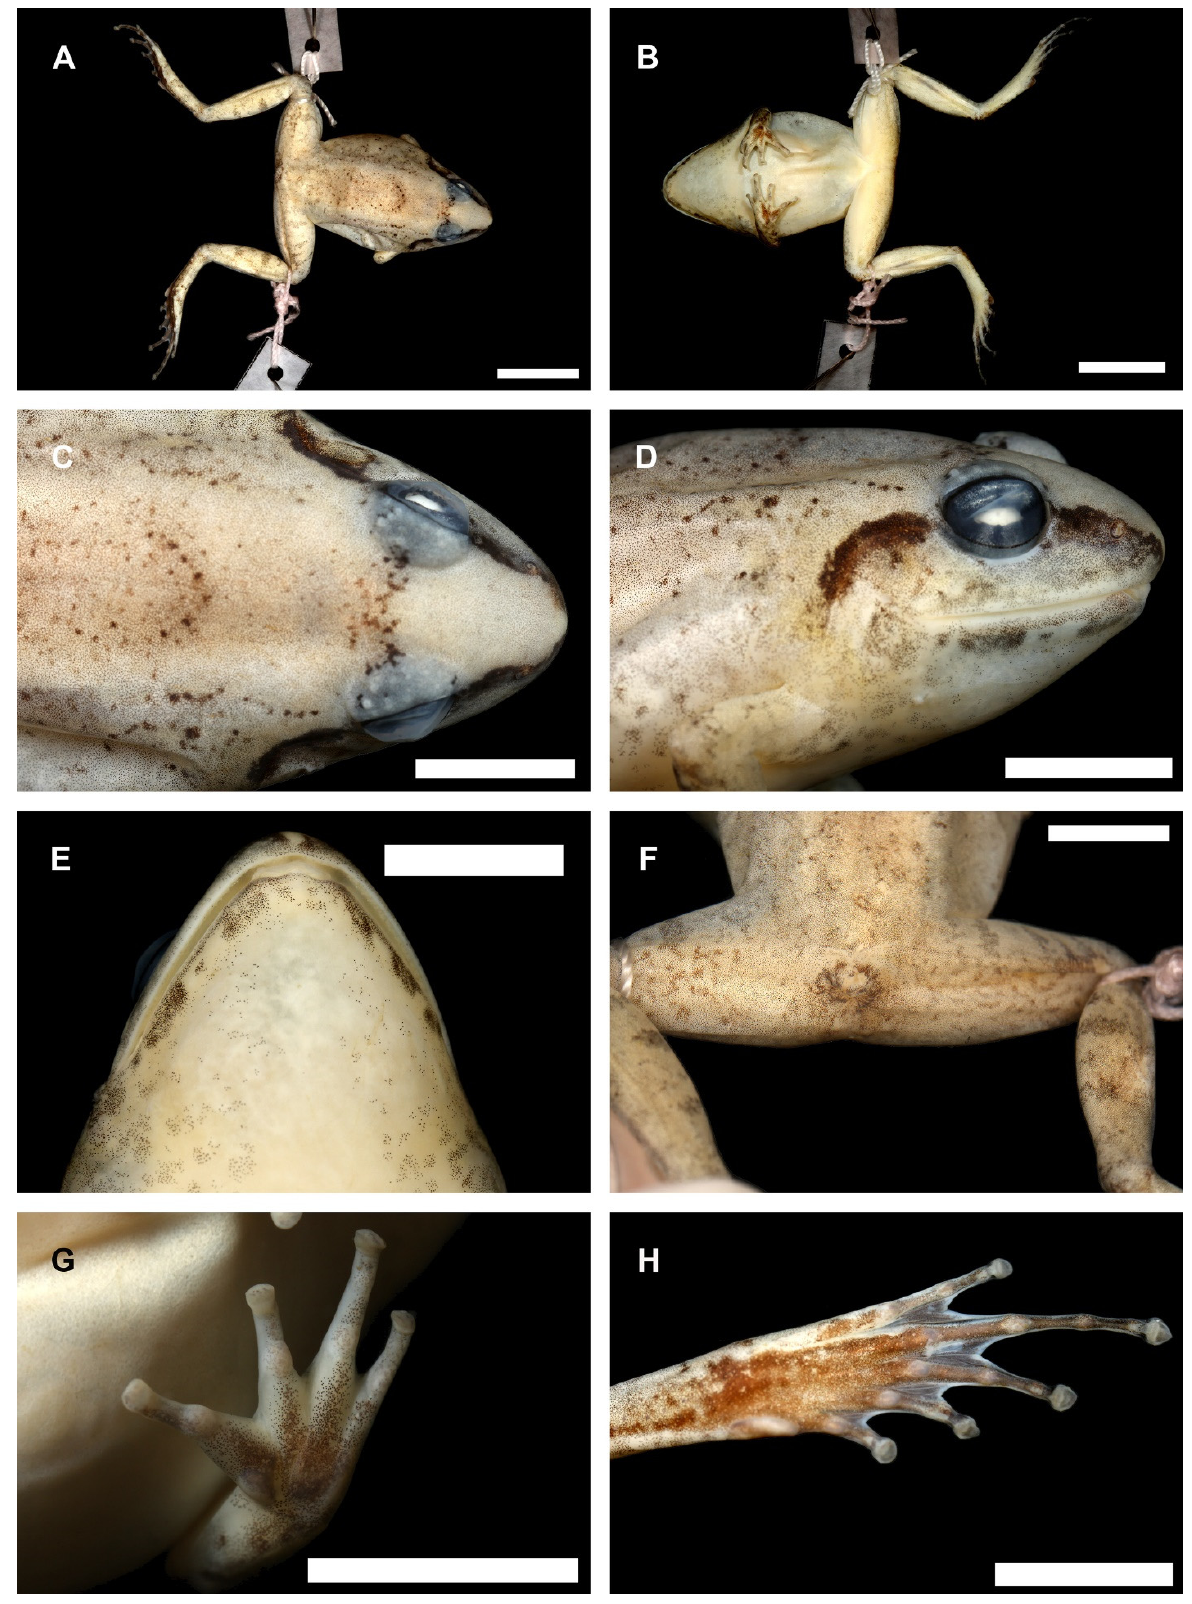
Figure 13. Holotype of Limnonectes bagoyoma n. sp . (SMF 106034). A. dorsal view; B. ventral view; C. dorsal view of head; D. lateral view of head; E. ventral view of head; F. cloacal and thigh region; G. palmar surface of hand; H. plantar surface of foot. Scale bars equal 5.0 mm. Photos by G.K.